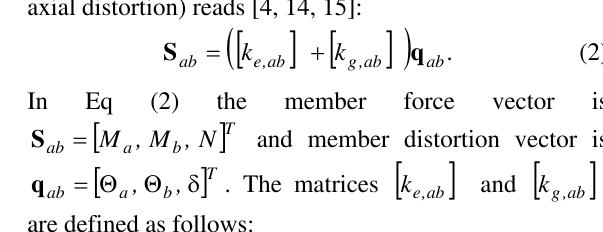
Fig 2. Member local forces and distortions The governing stiffness non-linear relationship of the end moment-axial forces of the member versus corre- sponding rotations and changes in the length (flexural